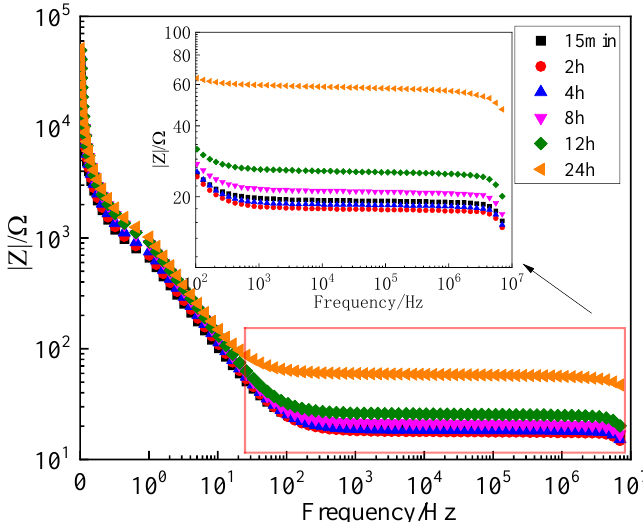
Figure 2. Bode plots with impedance modules of ordinary cement